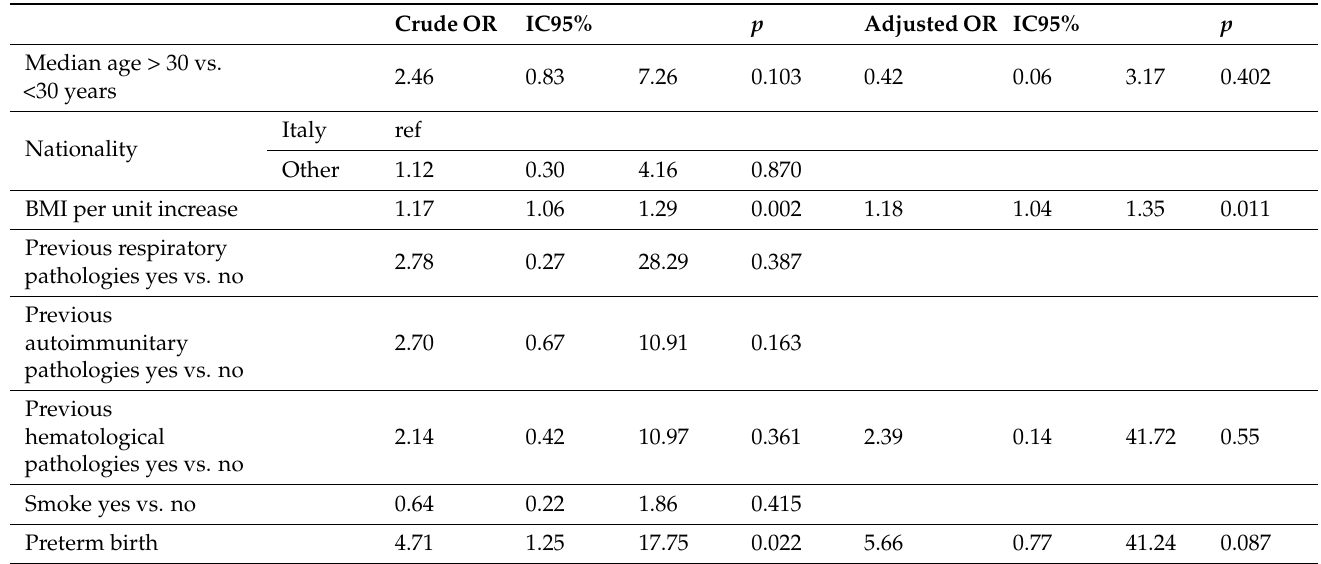
Table 4. Maternal univariable and multivariable analysis of factors associated to symptomatic COVID-19. Crude